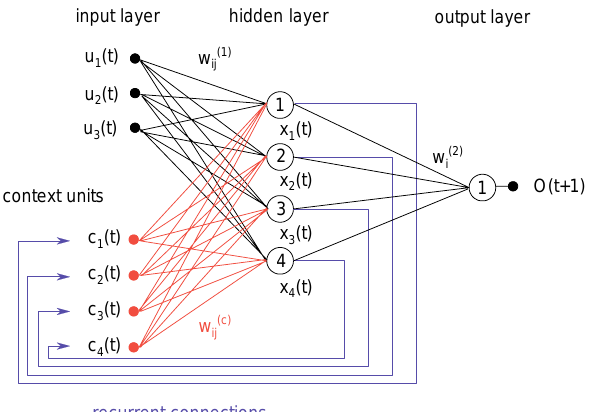
Fig. 2. The Elman scheme used for EDDA. u 1 , u 2 and u 3 are the inputs (normalized B z , B 2 and B 2 y ); w 0 s are the network weights. The blue lines indicate copying of each hidden layer output x into the corresponding context unit c , so that c k (t) = x k (t − 1 ) (see details in text).